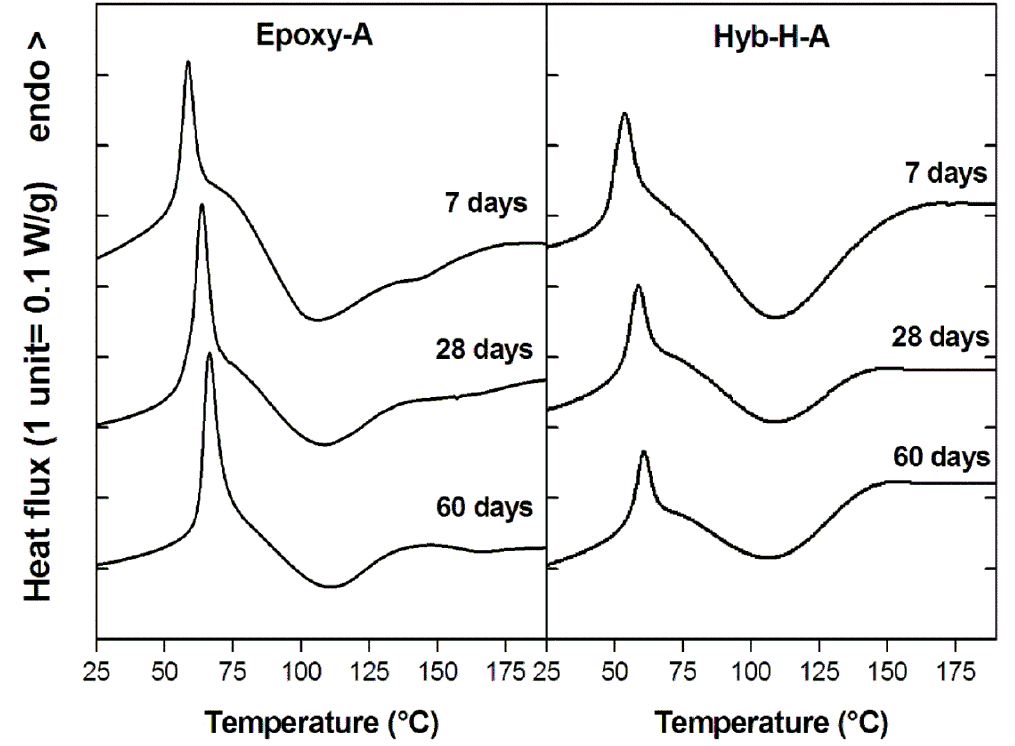
Figure 5. Dynamic DSC thermograms at 10 °C/min for Epoxy-A and Hyb-H-A systems aged at room temperature for different time spans.